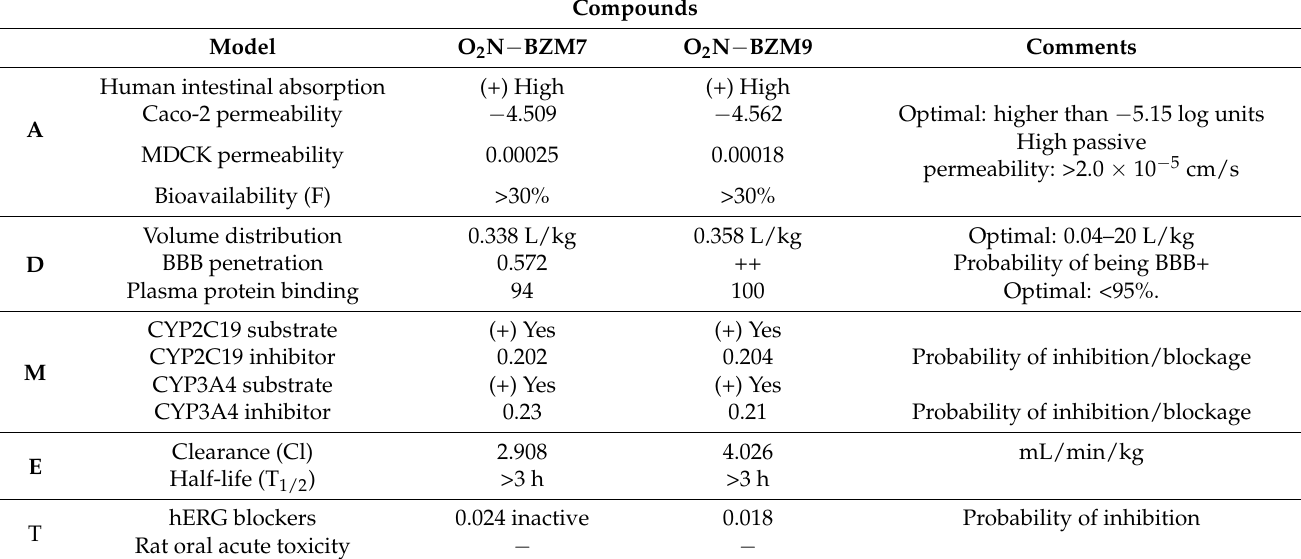
Table 4. Pharmacokinetic predictive values calculated with ADMETLab 2.0 for compounds O 2 N- BZM7 and O 2 N-BZM9 . Compounds